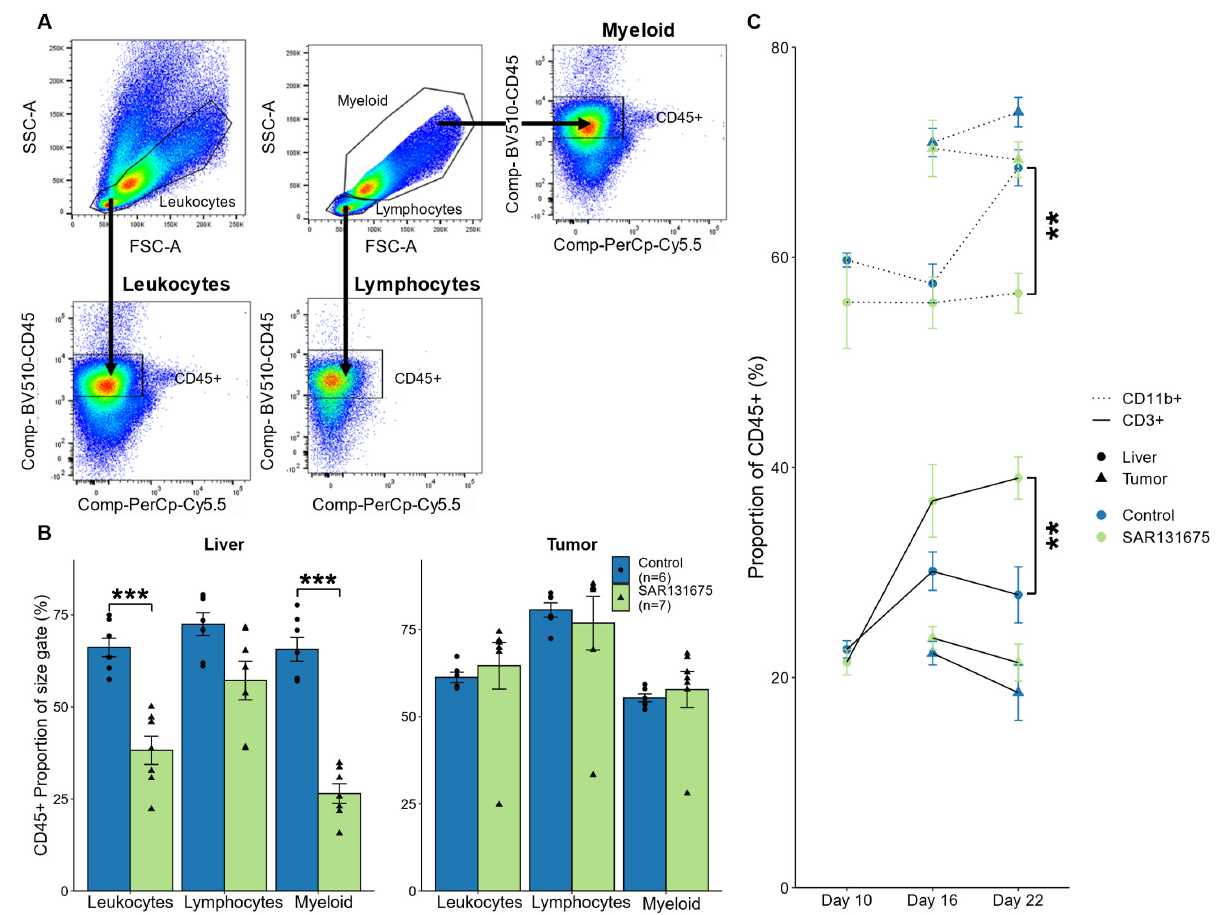
Figure 5. Percentage of CD3 + and CD11b + cells as a proportion of CD45 + leukocytes in liver and tumor. Following CRLM tumor induction and SAR131675 treatment, liver and tumor tissues were isolated and analyzed by flow cytometry at days 10, 16 and 22. ( A ) Live, single, non-auto fluorescent cells within size and granularity gates for small lymphocytes, myeloid cells and a combination of both (Leukocytes) were analyzed for CD45 + staining. ( B ) The percentage of CD45 + leukocytes as a proportion of all live cells within the selected size gates on day 22. ( C ) The percentage of CD3 + and CD11b + cells as a proportion of CD45 + cells in the combined leukocyte size gate at each time point for liver and tumor tissues. Significance is indicated by * while non-significance is unmarked (** p < 0.01 and *** p < 0.001).